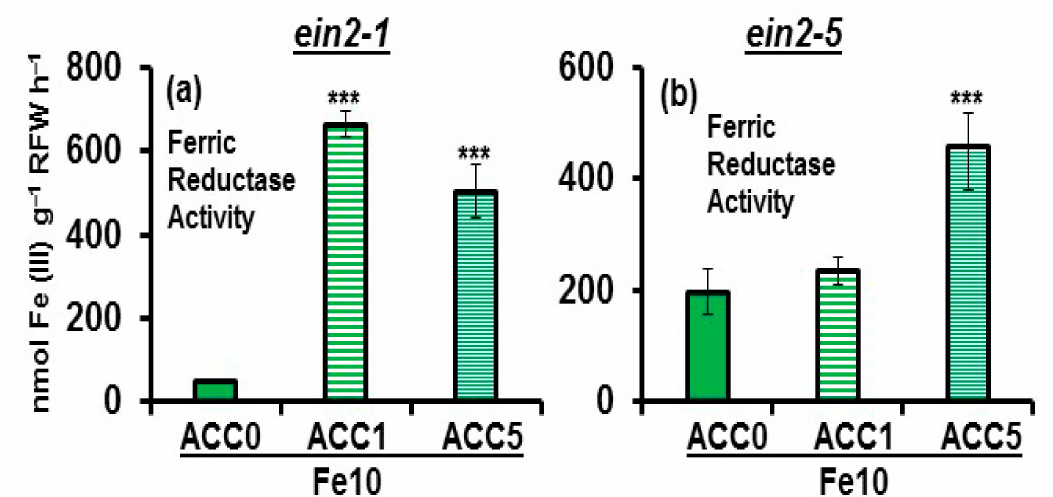
Figure 5. Effect of ACC (ET precursor) on the ferric reductase activity (FRA) of Fe-sufficient Arabidopsis ET insensitive ein2-1 ( a ) and ein2-5 ( b ) plants. Treatments as in Figure 4. After treatments, FRA was determined. Data represent the mean of 6 replicates ± S.E. Bars with *** indicate significant differences ( p < 0.001) in relation to the Fe10 treatment according to the Dunnett’s